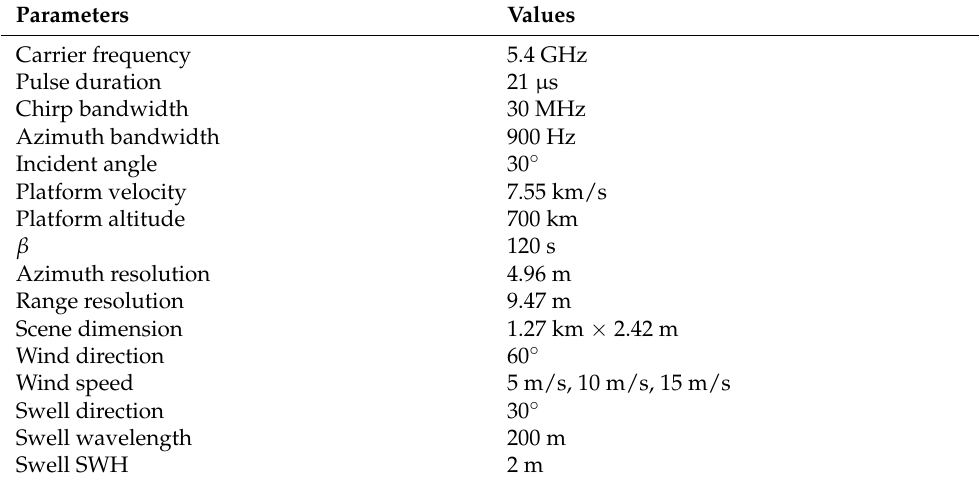
Table 4. The input parameters of radar and ocean